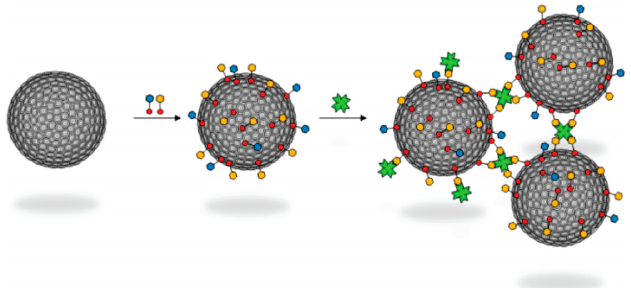
Figure 7. Schematic representation of carbohydrate-decorated cyclodextrin vesicle agglutination induced by the lectin ConA (green) in the presence of a maltose–adamantane conjugate (orange/red). Similarly, agglutination of cyclodextrin vesicles can be induced by PNA (not shown) in the presence of a lactose–adamantane conjugate (blue/red). Reprinted with permission from [72]. Copyright 2011, American Chemical Society.